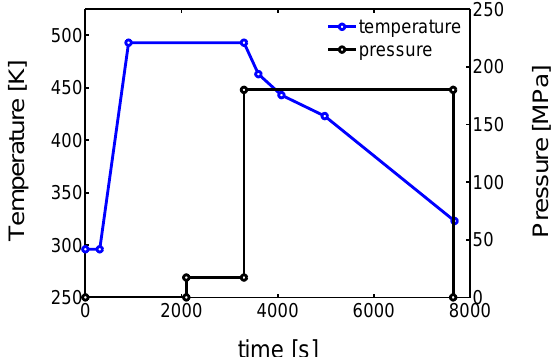
Figure 1. Schematic of the pressure-temperature protocol, used to prepare γ -iPP samples.